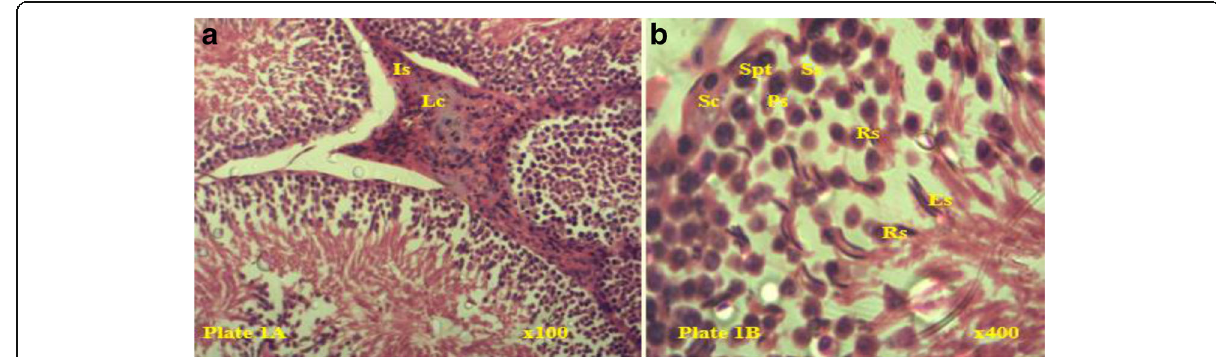
Fig. 5 a , b Photomicrograph of testes of the control group: Representative testicular micrograph of Wistar rats showing normal “ control ” structure of seminiferous tubules. Sc Sertoli cells, Lc Leydig cell, Spt spermatogonia, Ss Secondary spermatocytes, Ps Primary spermatocytes, Es elongated spermatids, Rs Round Spermatid, It Interstitial space, Spz spermatozoa. The stain is H&E and Magnification x 100 and x 400